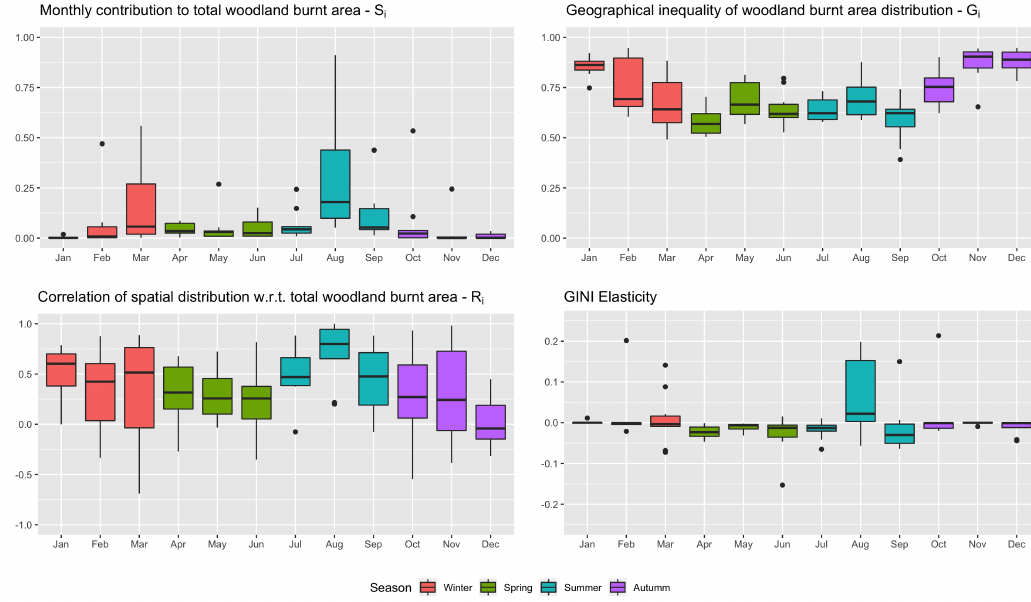
Figure 6. Spatial Gini decomposition of burned woodland area per